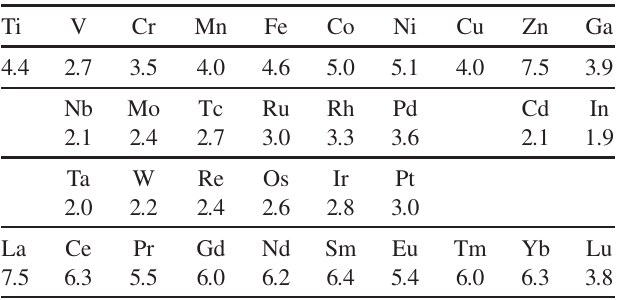
TABLE I. Values of U parameters (in eV) for the Dudarev’s eff GGA þ U approach implemented in AFLOW . Data taken from Ref. [10] and references